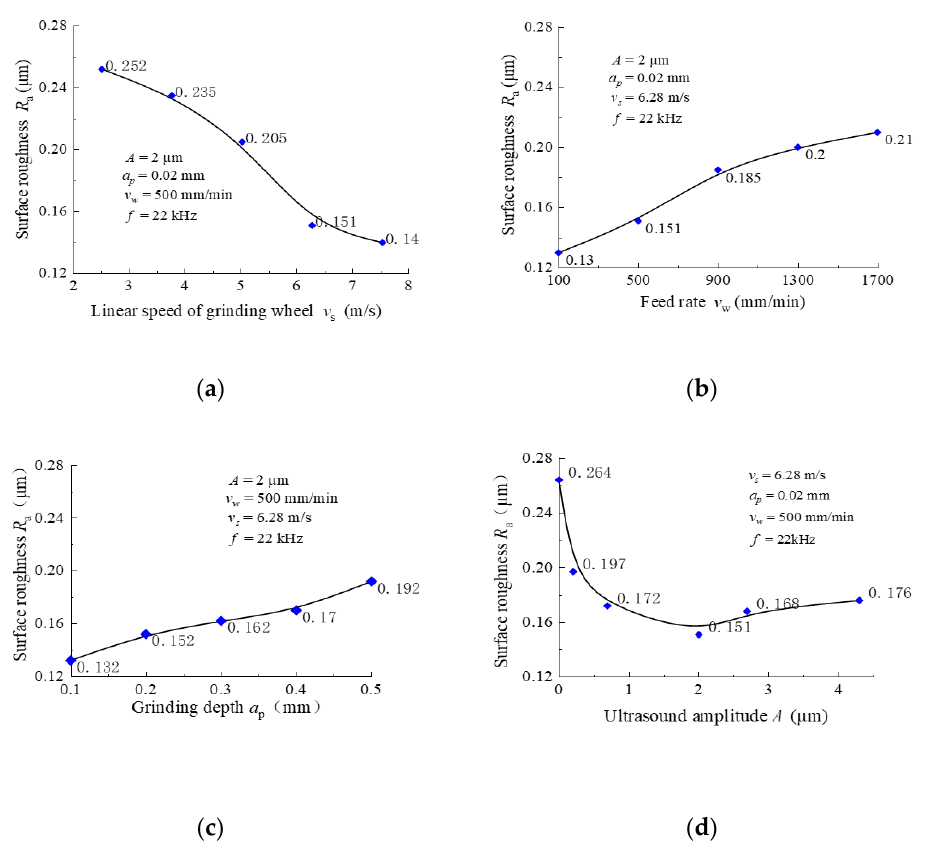
Figure 6. Relationships between surface roughness and each grinding factor after ultrasonic vibra-